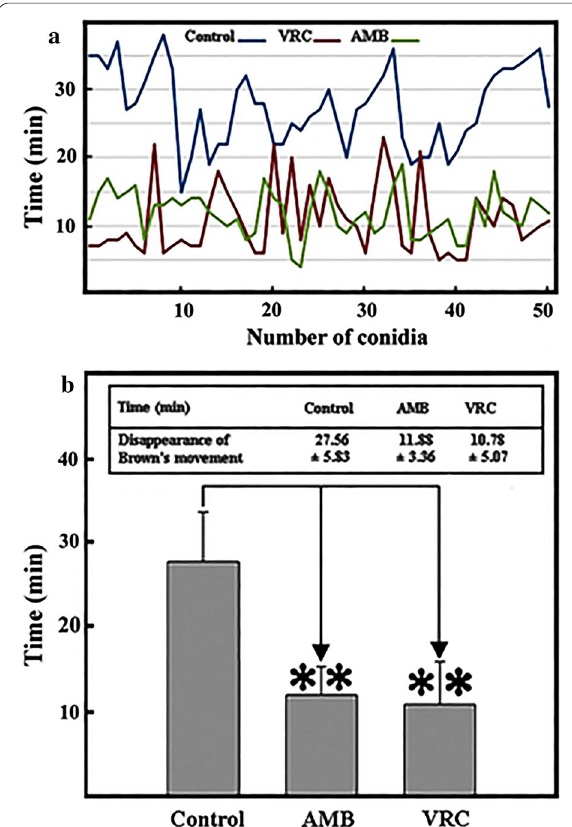
surface in the absence and presence of antifungal agents. a Control: Time of disappearance of Brown’s movement of 50 conidia in the absence of antifungal agents (upper blue line). Effect of antifungal agents: average time of disappearance of Brown’s movement of a selected population of 50 conidia in the presence of AMB (green) and in the presence of VRC (red). b Average time of adherence measured in selected populations of conidia. Data are presented as mean **p < 0.01 considered as statistically highly significant